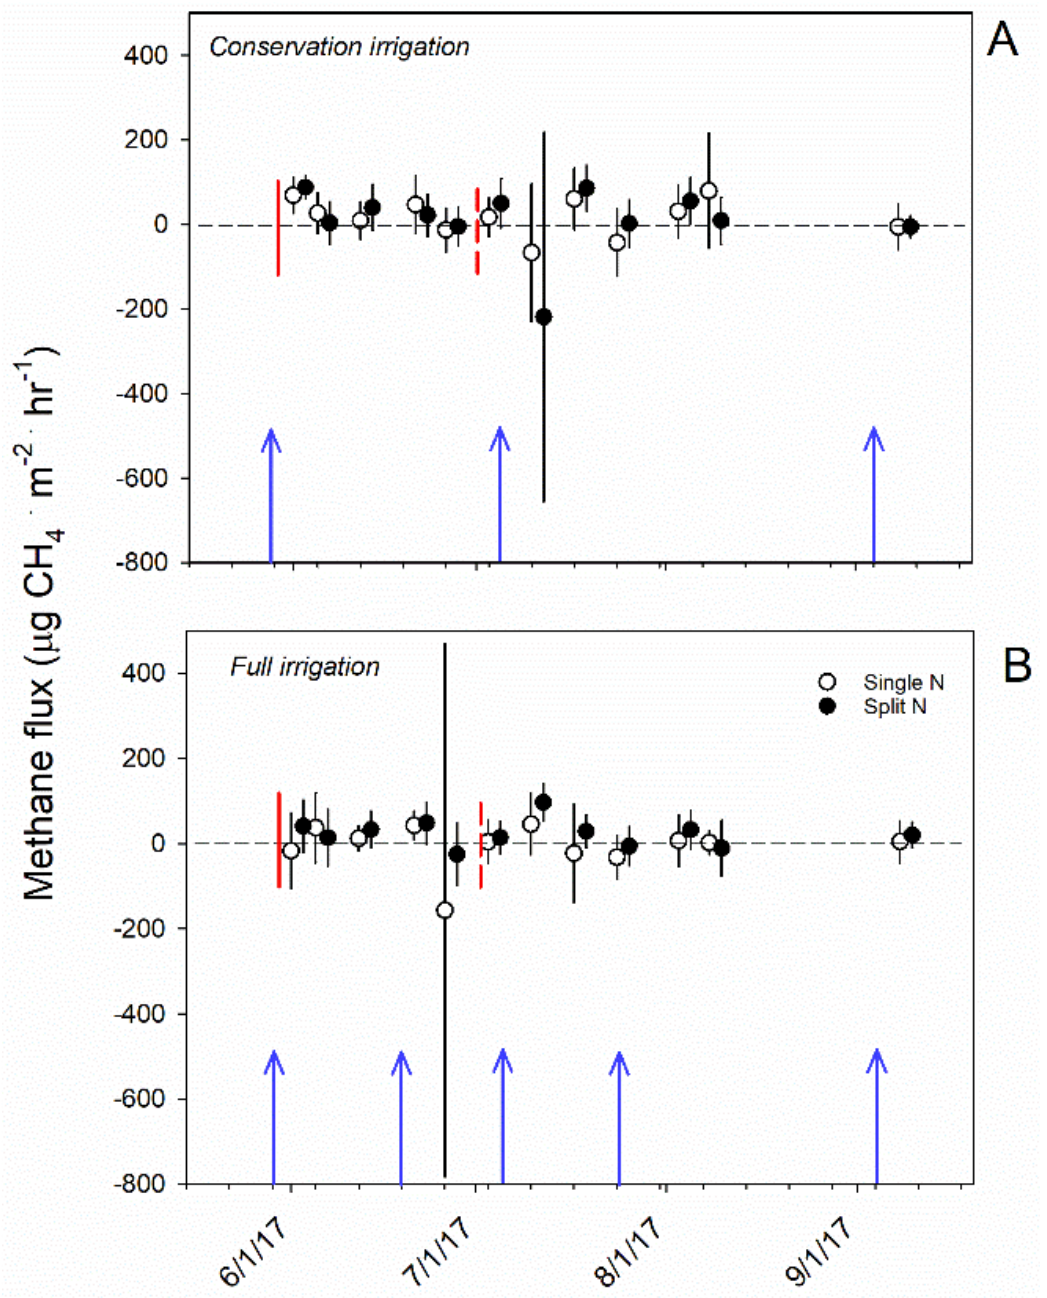
Figure 9. Soil methane (CH 4 ) flux from a sorghum field under ( A ) 30% less irrigation and ( B ) full irrigation, and with N fertilizer applied once at the start of the growing season or split between two applications. Red vertical lines denote when fertilizer was applied (second application timing for split = dashed line). Blue arrows denote irrigation events. Values are µ g CH 4 · m − 2 · hr − 1 , mean flux per treatment per sample date ± 1 SD.